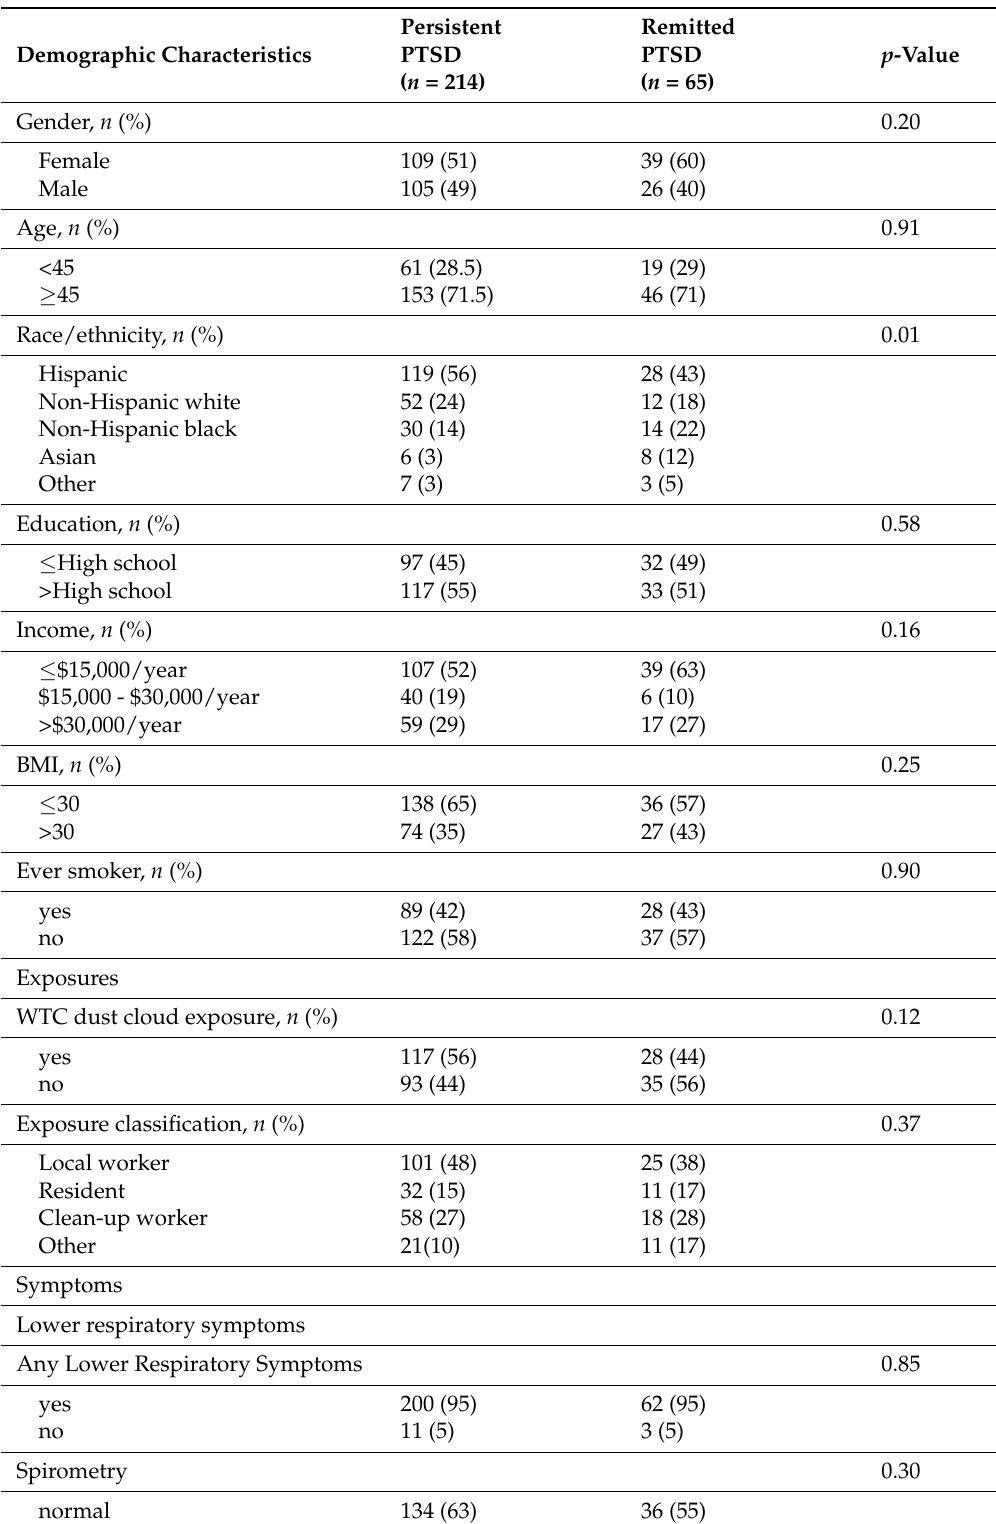
Table 2. Characteristics associated with Persistent and Remitted PTSD